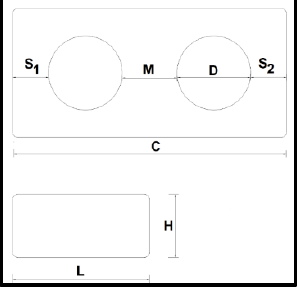
Figure 2. Scheme-indicated measure.